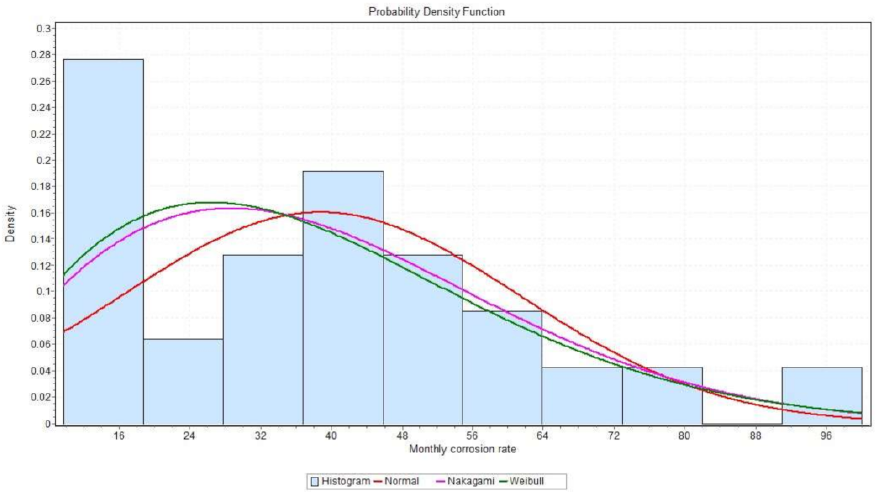
Figure 8. Probability density function (PDF) graphics for the three best fitted two-parameter distribu- tions for air